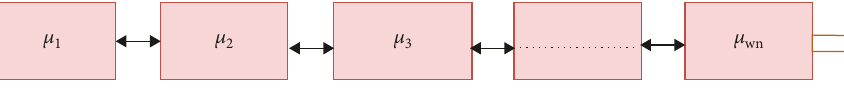
Figure 4: Solution